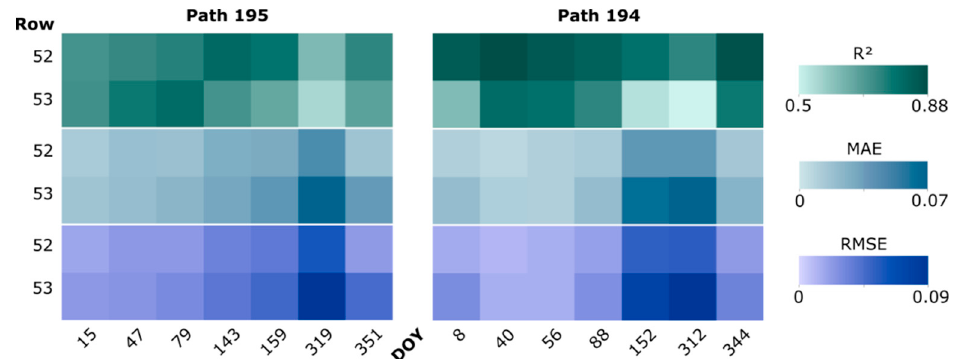
Figure 7. Landsat false color composite (NIR-R-G, row 1 ), mean annual NDVI (year 2014) derived from MODIS ( row 2 ), ESTARFM ( row 3 ) and Landsat ( row 4 ) for three focus areas: a fragmented landscape area in the south of Burkina Faso ( left column ), the city of Ouagadougou in Burkina Faso ( middle column ) and the Mole National Park in Ghana ( right column ).